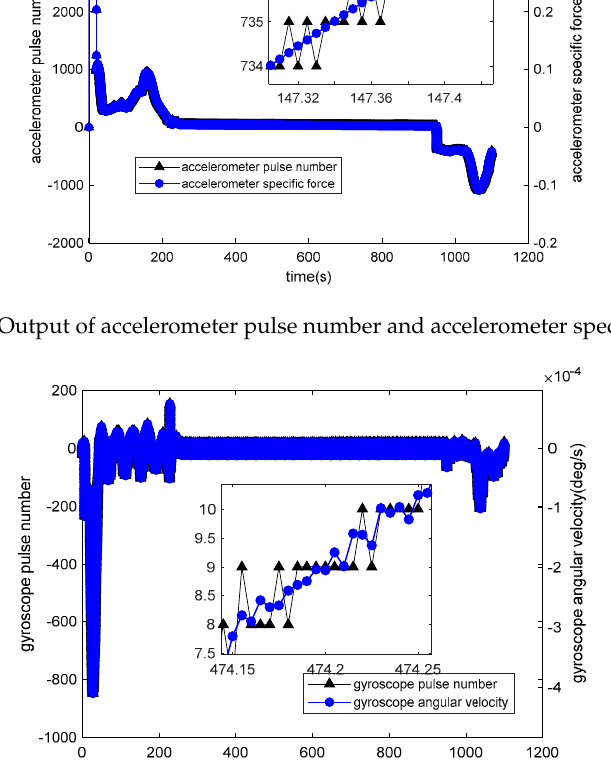
Figure 10. Output of gyroscope pulse output and gyroscope angular velocity.